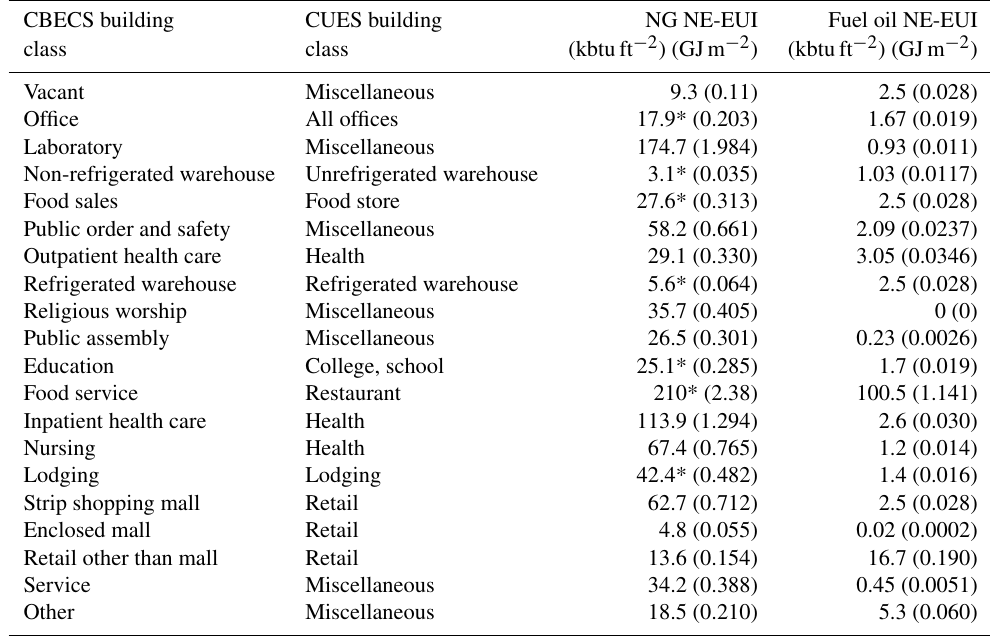
Table 3. Building type relationship and NE-EUI values for commercial buildings derived from the CBECS and CUES